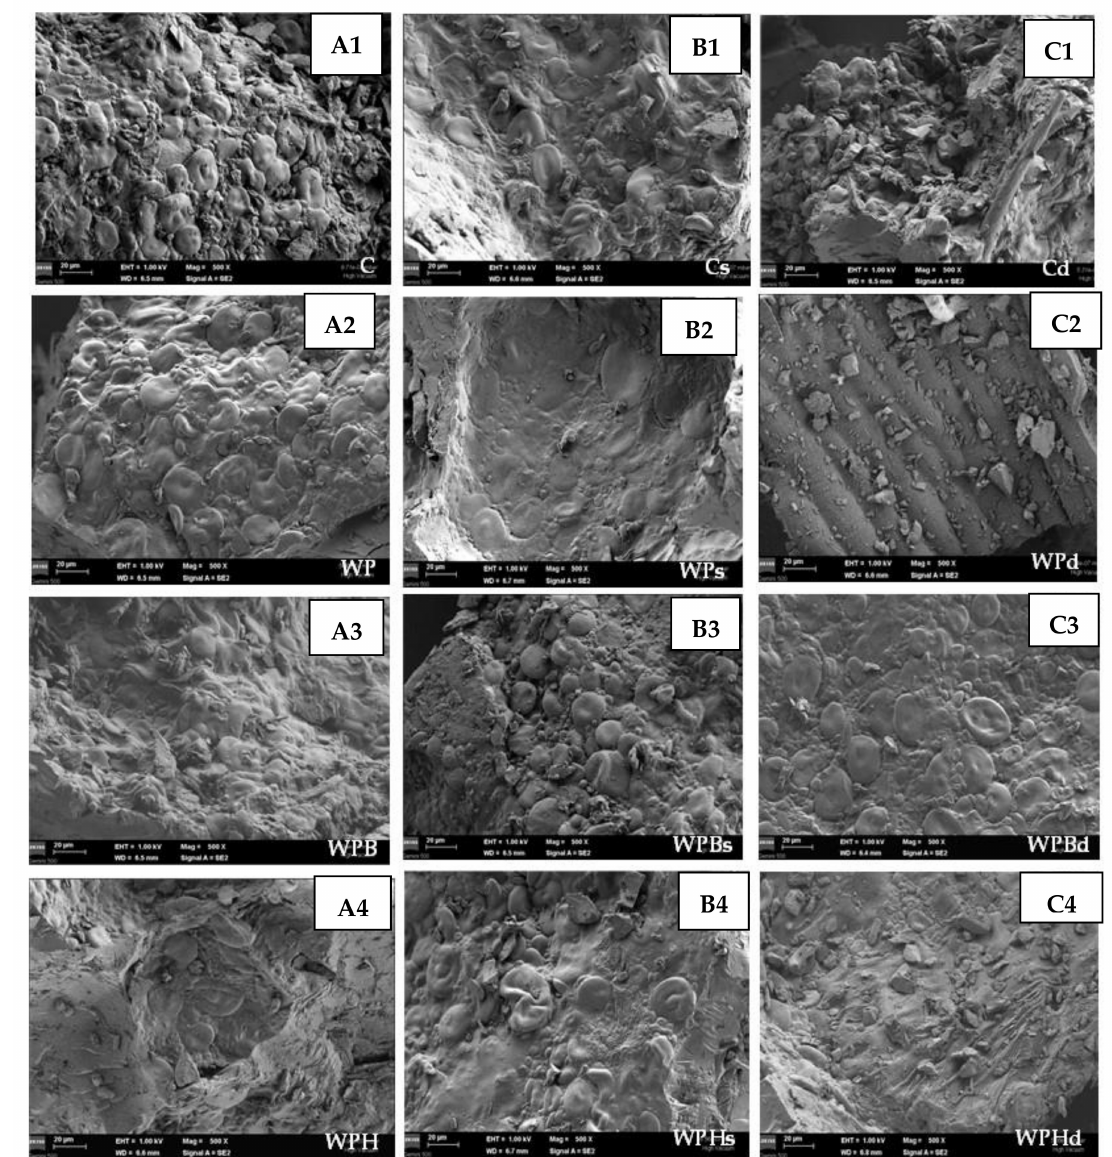
Figure 5. Microstructure of bread crumb samples. ( A1 – A4 ) samples obtained through direct bread making process; ( B1 – B4 ) samples obtained through indirect bread making process (sponge and dough); ( C1 – C4 ) samples obtained through indirect bread making process with dried sourdough. C- control from whole wheat flour; WP-whole wheat flour + 2% pea concentrate; WPB-whole wheat flour + 1% pea concentrate + 2% sea buckthorn ingredient; WPH-whole wheat flour + 1% pea concentrate + 2% hemp